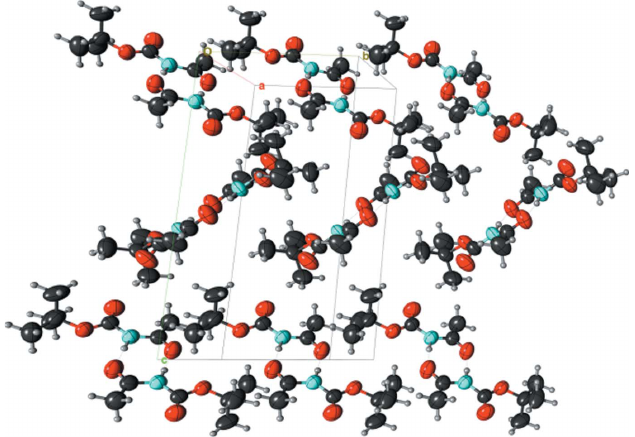
Figure 3 Molecular packing of (I), viewed along the a axis, showing different orientations of the dimers.